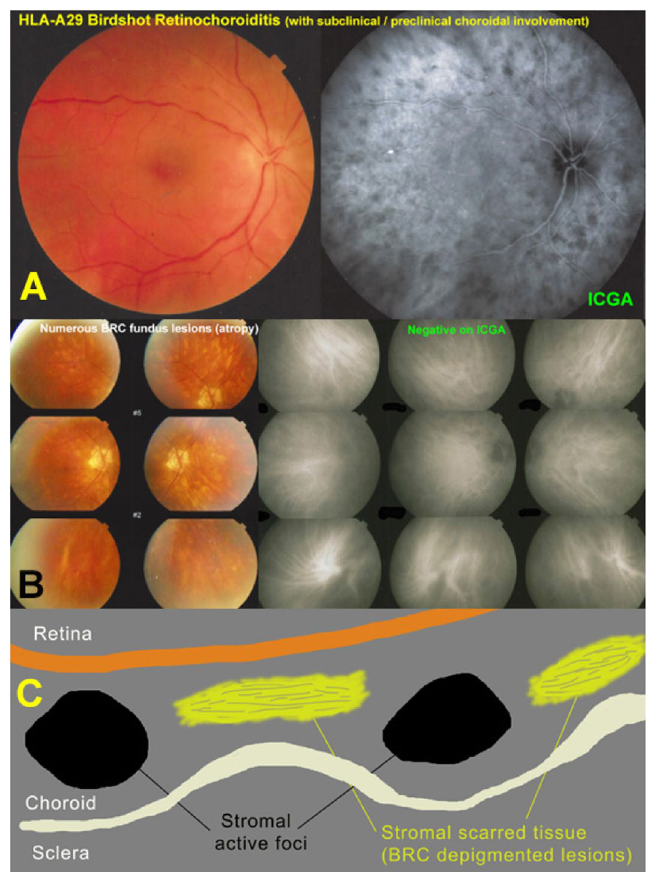
Fig. 2 HLA‑A29 BRC. ICGA is essential for early diagnosis of disease and for monitoring disease activity. A Patient complaining of floaters and “dim” vision. Because of bilateral oedematous optic discs, an angiography was performed showing numerous HDDs on ICGA in the posterior pole and midperiphery (top right). HLA‑A29 testing was positive. B BRC patient who had been treated with immunosuppressives, with numerous cream‑coloured BRC fundus lesions, who’s ICGA did not show any HDDs, indicating inactivity of disease. C cartoon inspired from Mirò, showing that cream coloured BRC lesions are choroidal scars (yellow discs), (not appearing on ICGA), while black round spheres represent active choroidal foci identified by ICGA. Fundus lesions and HDDs on ICGA should not be